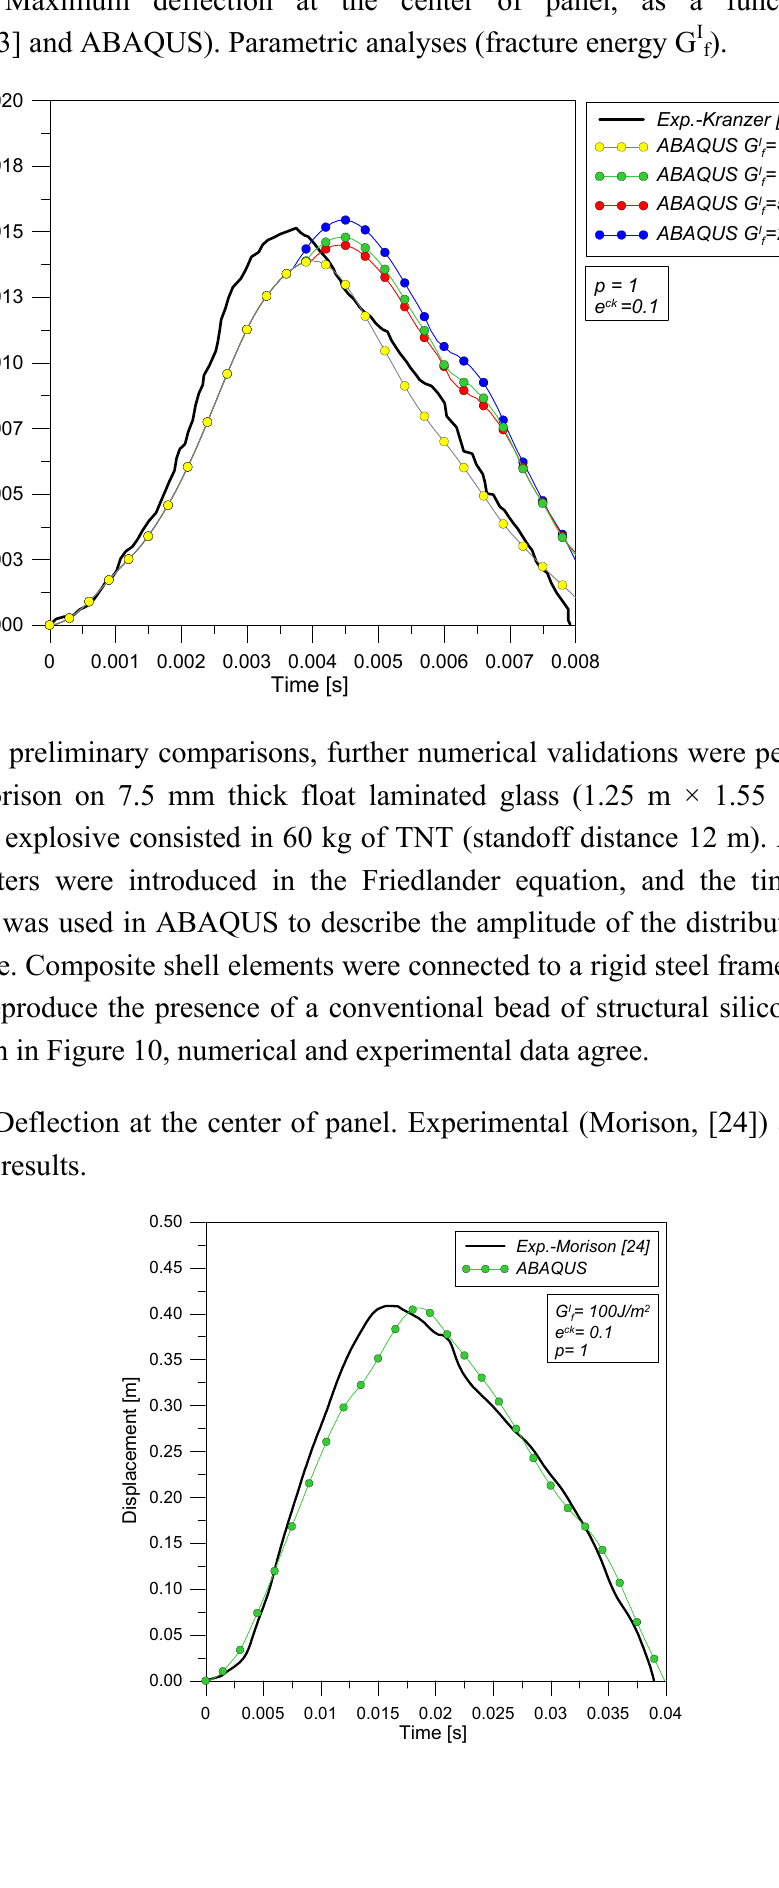
Figure 9. Maximum deflection at the center of panel, as a function of time (Kranzer, [23] and ABAQUS). Parametric analyses (fracture energy G I